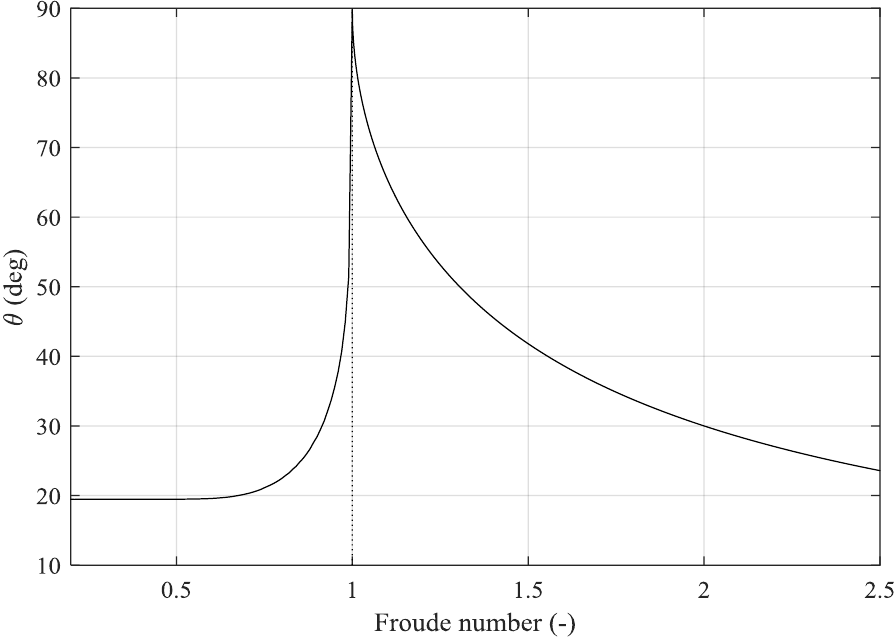
Figure 1. Kelvin half-angle of ship-generated waves in shallow waters as a function of the depth Froude number.